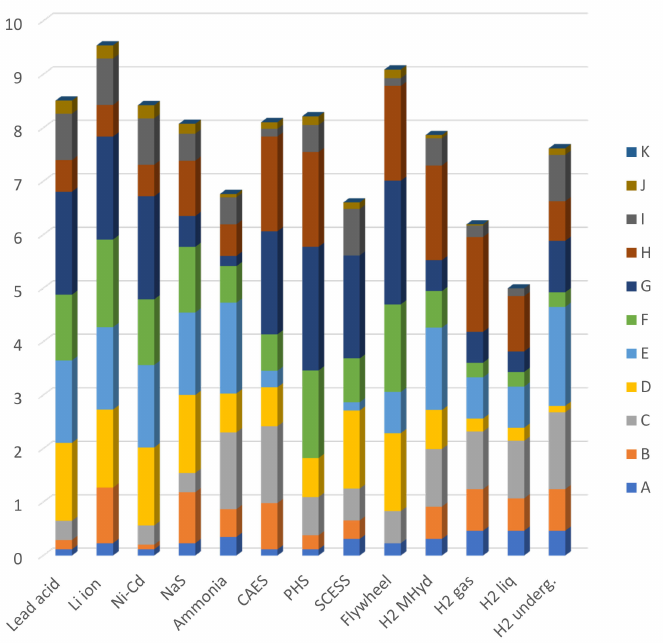
Figure 11. Performance of storage solutions per KPIs—Scenario B-2050. A–K are the KPIs. (A) Mass energy density, (B) Energy content per footprint, (C) Discharge duration, (D) Response time, (E) Capacity, (F) Efficiency, (G) Safety, (H) Environmental impact, (I) Maintenance, (J) Integrability and (K)